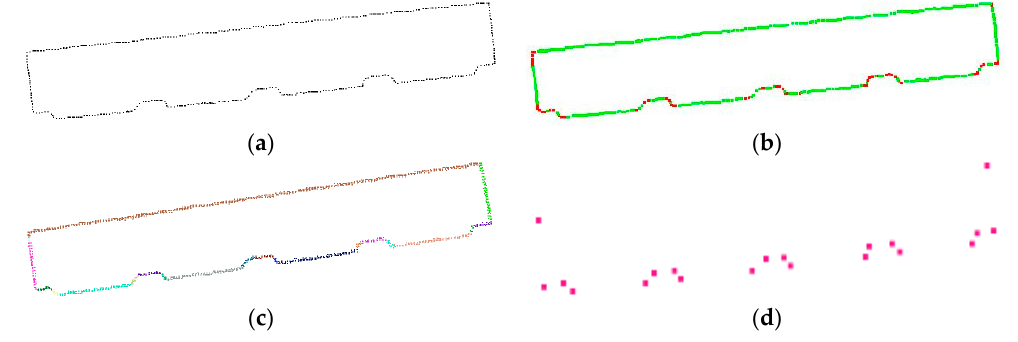
Figure 8. Results of each step: ( a ) sorted boundary points; ( b ) result after corner detection (red areas); ( c ) subsets divided by the corners; and ( d ) accurate corner points.